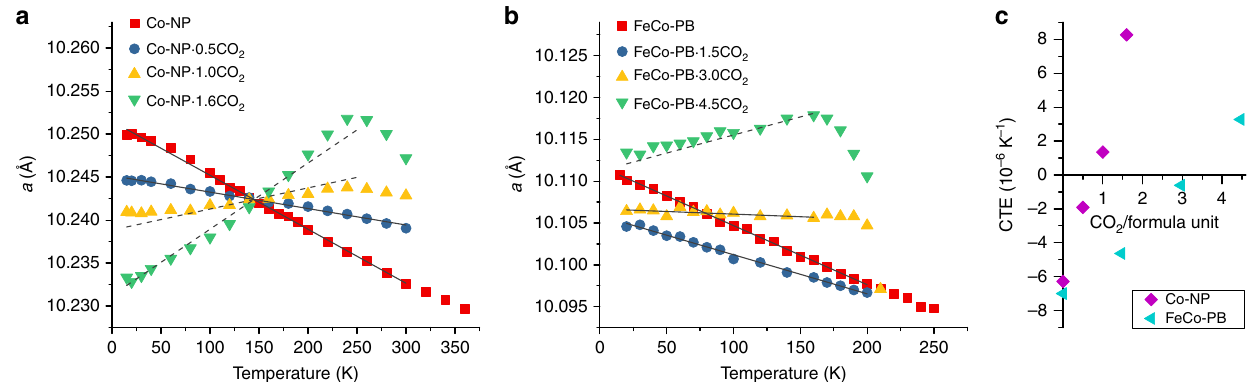
Fig. 2 CO 2 -dependent thermal expansion trends for Co-NP and FeCo-PB. a , b Symbols represent the experimentally determined cubic lattice parameters of Co-NP and FeCo-PB at various CO 2 loadings and temperatures. Error bars are smaller than the symbols. Solid lines represent linear regression fi ts over limited data ranges (see Table 1); these fi ts were used to parameterise the formulae derived in the text (see Eqs. (1) and (2)). The dashed trend lines are predicted by the parameterised model. c Evolution of the CTE values obtained by linear regression fi ts against all data series Table 1 Coef fi cients of thermal expansion obtained by linear Table 2 Parameter values determined for the prediction of regression fi ts to re fi ned lattice parameters guest-dependent thermal expansion trends in Co-NP and x (CO 2 guests per formula unit) Co-NP (using Eq.